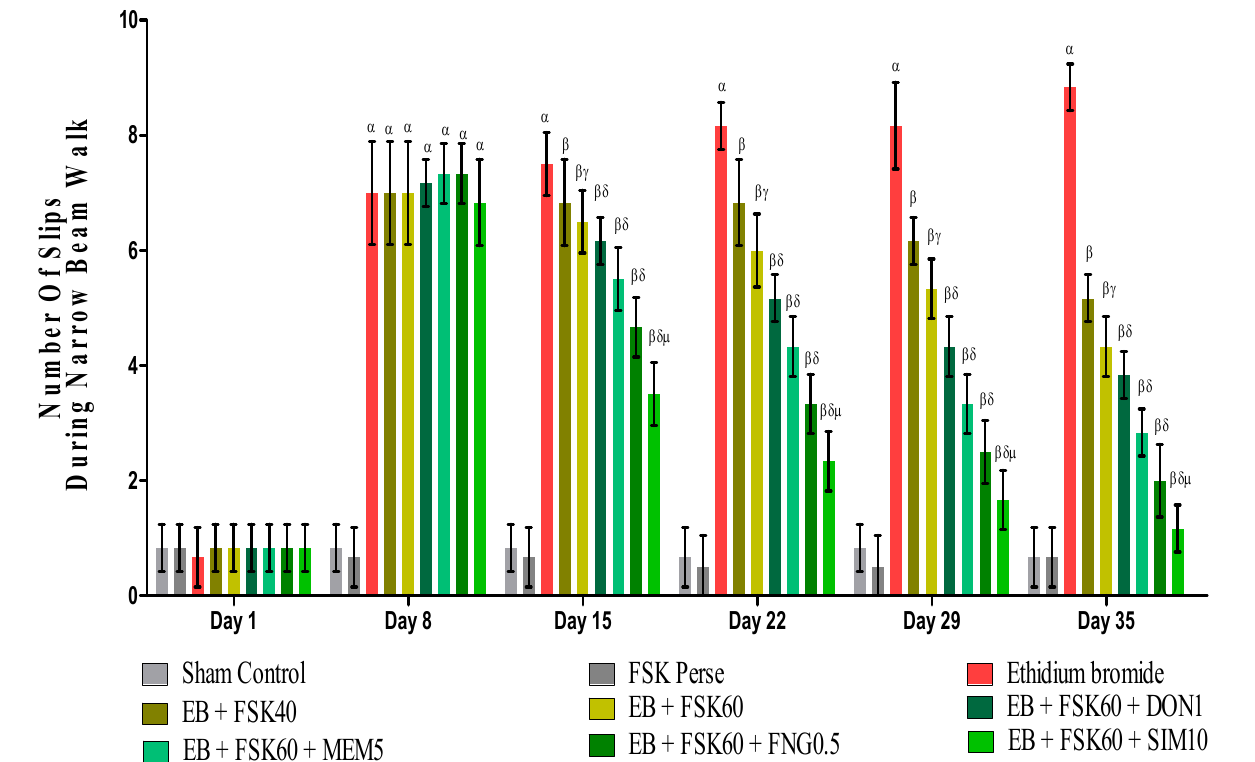
Figure 5. Protective role of FSK during Narrow Beam Walk in experimental multiple sclerosis rats. Analysis of Variance (ANOVA) with Bonferroni’s post hoc test was used to evaluate the data, which were presented as mean with SD ( n = 6). α EB (p < 0.01) v / s Sham control and FSK40 perse; β EB